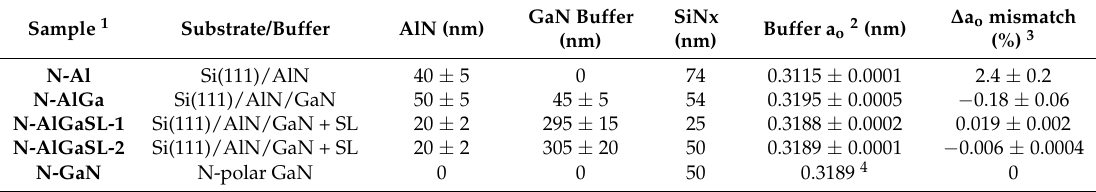
Table 1. Structure and in-plane lattice mismatch for the N-polar buffers